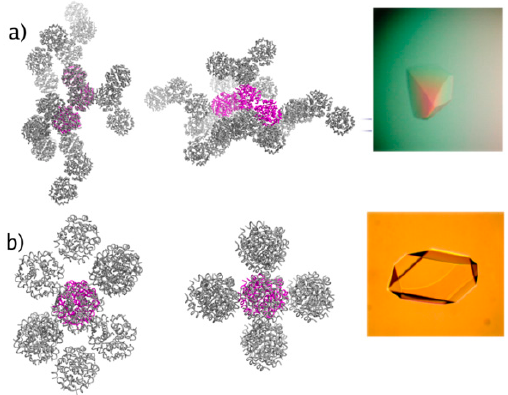
Figure 4. Structural models derived from single crystal methods. Packing of ( a ) C 222 1 and ( b ) C 2 insulin hexamers. The asymmetric unit is denoted in both cases with magenta. Single crystals of